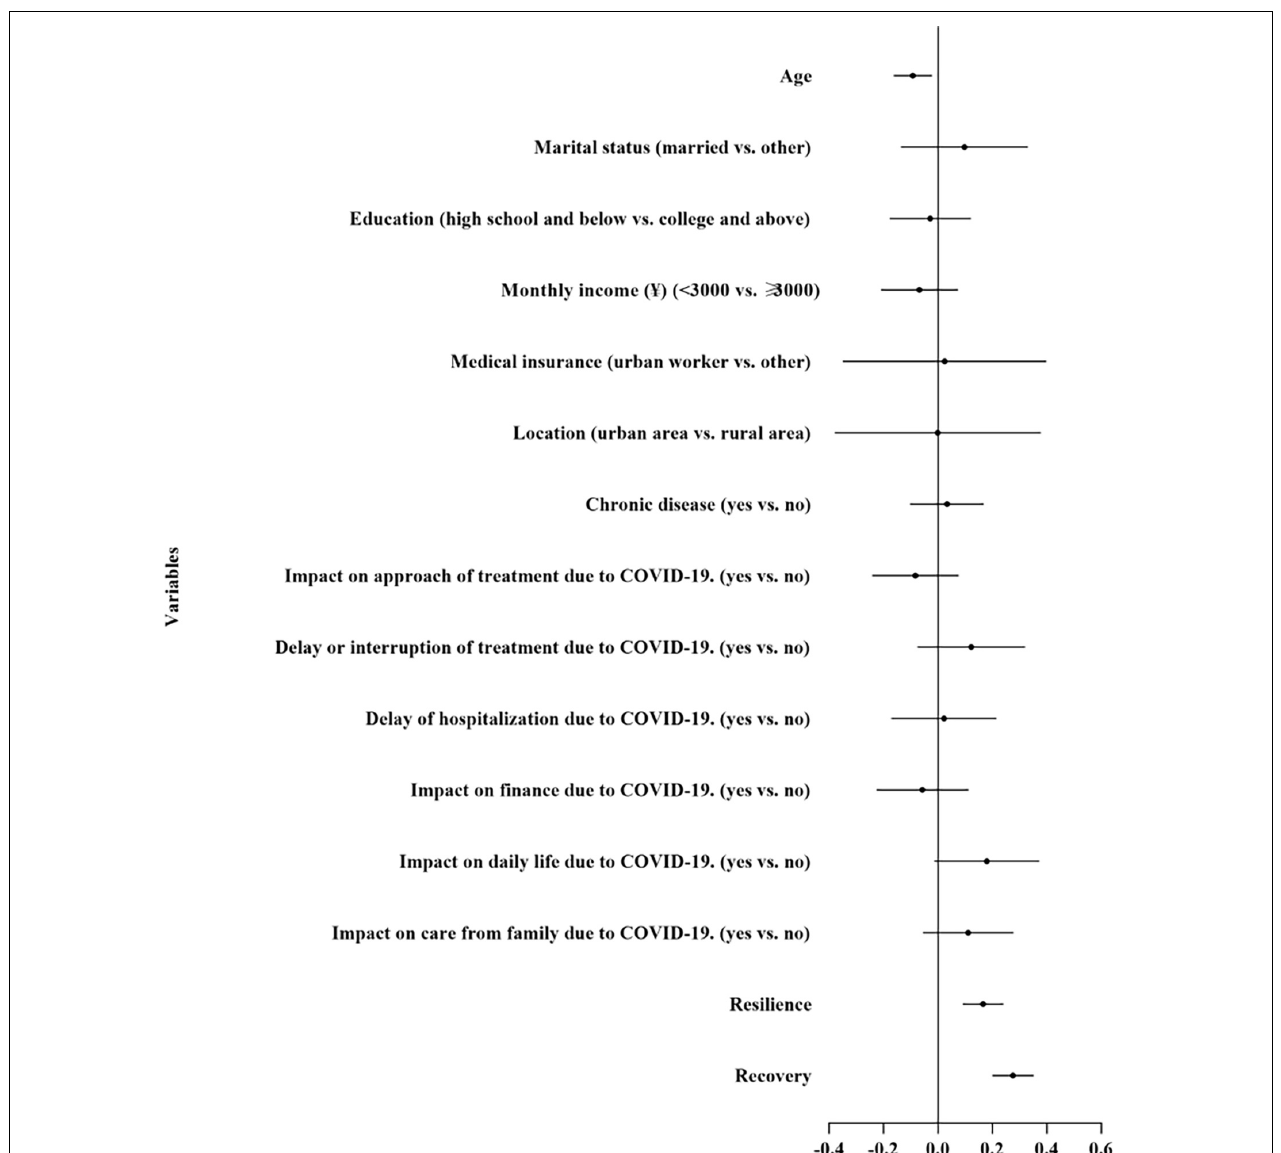
FIGURE 1 | Forest plot of associated factors of posttraumatic